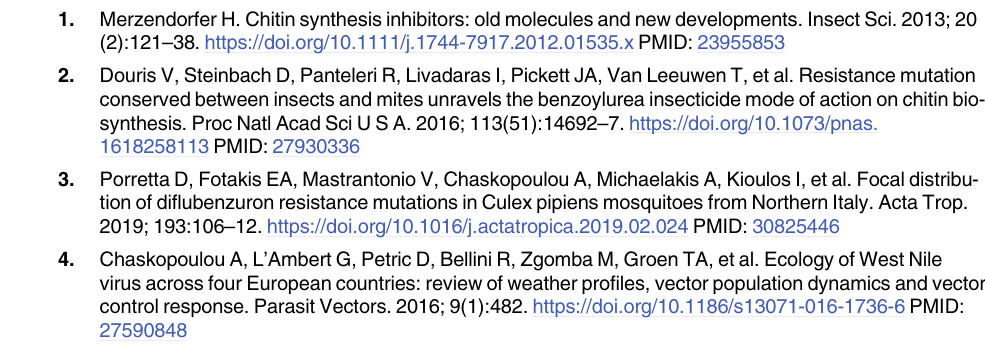
S1 Fig. Chromatograms showing susceptible (II) and resistant genotypes (LL, IL, IM, MM, FL, FM) found in the Cx . pipiens individuals analysed. The site where the mutations occur in the CHS gene is highlighted with a black circle. S1 Table. Study site